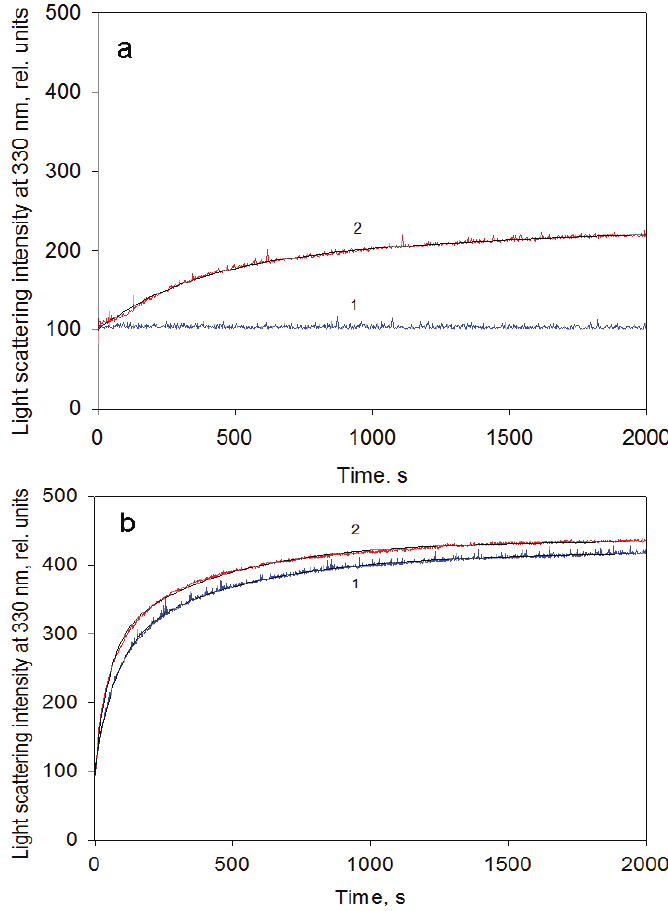
) SO , 0.4 M urea and 10 mM 4 2 4 :GroES = 14 7